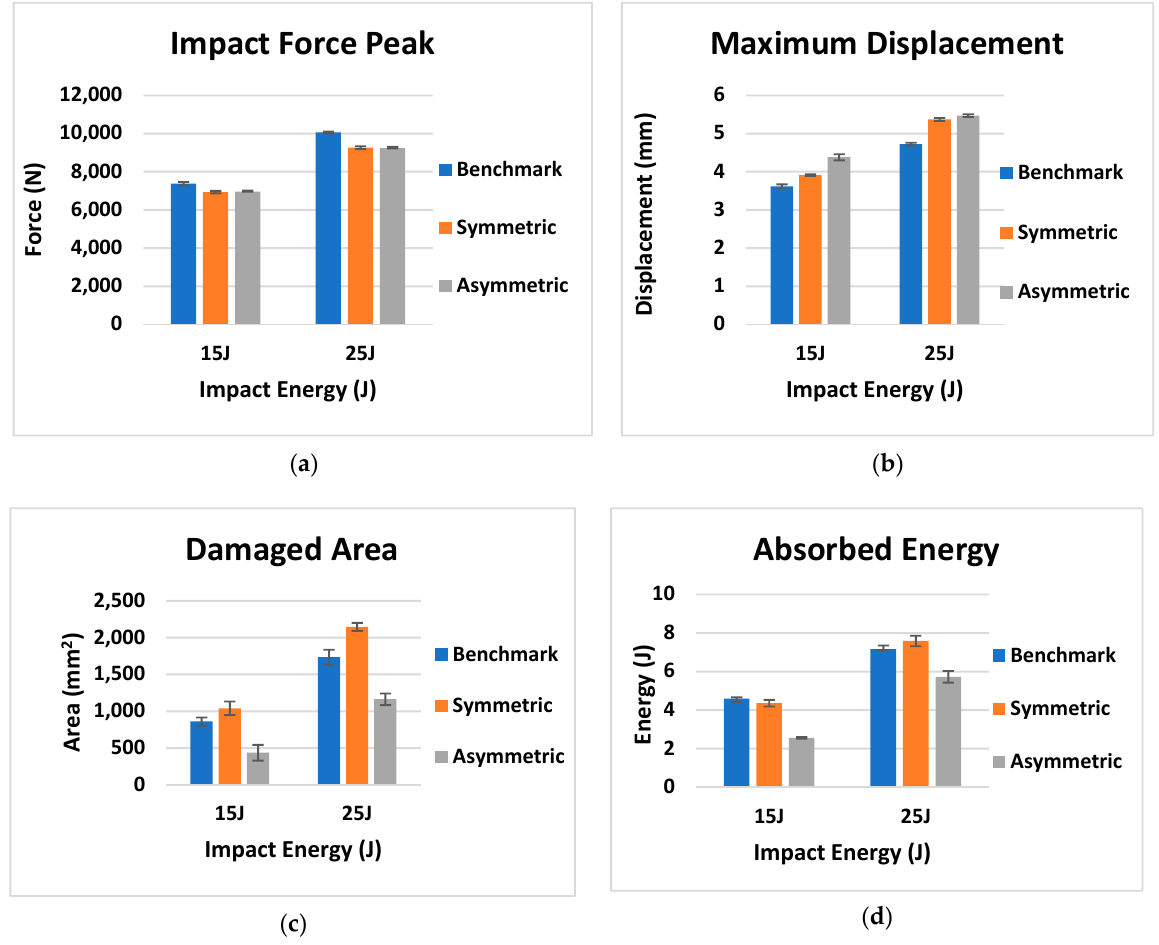
Figure 11. Force–displacement curves for the benchmark, symmetric and asymmetric configurations.